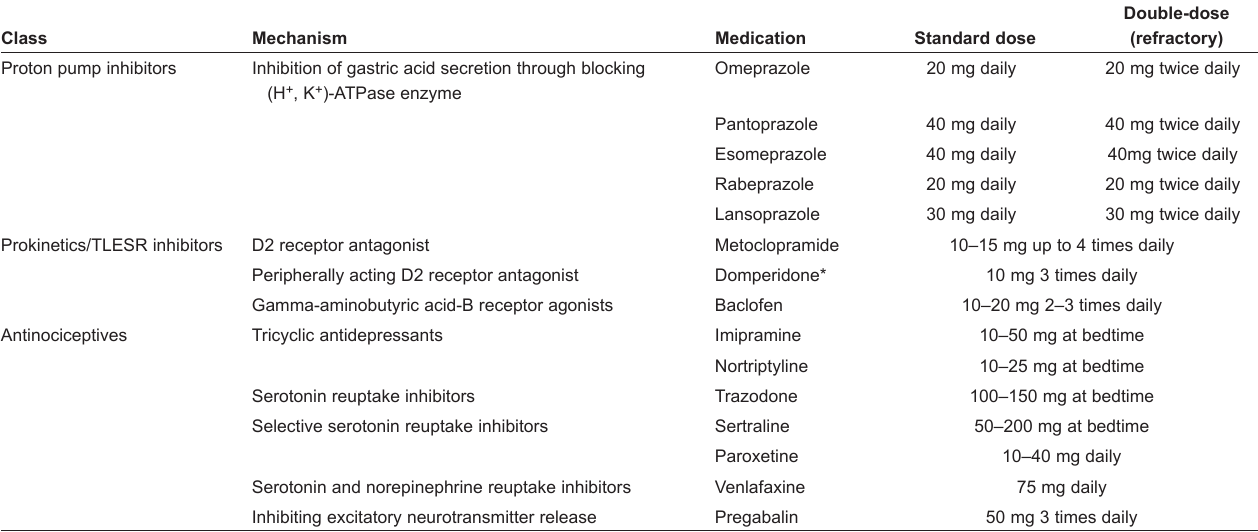
TAble 1 Potential medications for gastroesophageal reflux